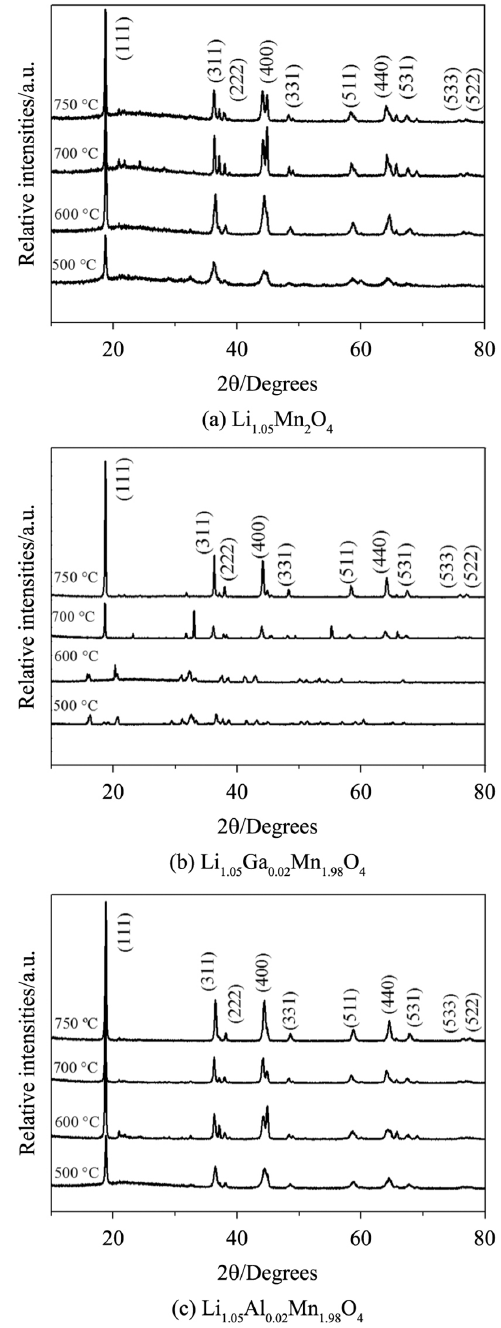
Mn O ; (b) Li Ga Mn O 1.05 2 4 1.05 0.02 1.98 4